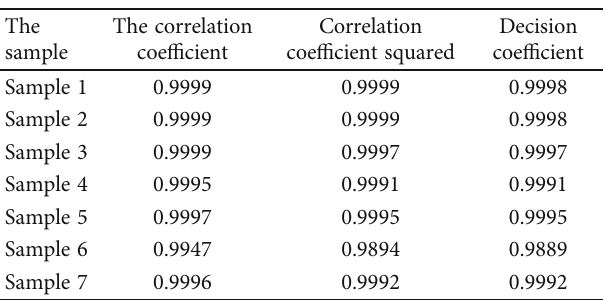
Figure 4: Fitting diagram of gas content in SZ block. Table 1: Data from 7 samples from 2